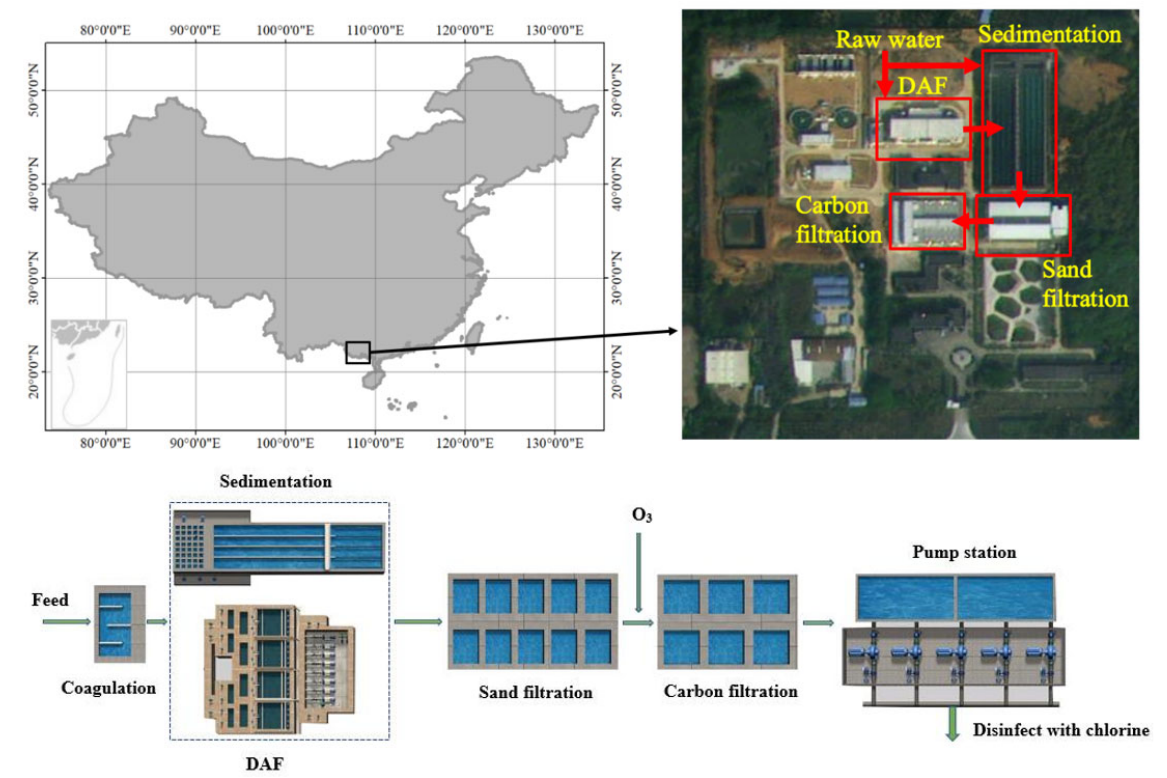
Figure 1. The water treatment process in Beijiao DWTP, Beihai, China. The scale of the feed was 96,000 m 3 ∙ d − 1 , and the dosages of the ozone and liquid chlorine were fixed at 1.6 mg ∙ L − 1 and 3 mg ∙ L − 1 , respectively. The sand filtration was backwashed every 24 h with a flow of 1440 m 3 ∙ s − 1 , with 8 min of air backwashing and 8 min of water backwashing. The activated carbon filtration was backwashed every 7 days with an 8 min water wash and every 30 days with a 5 min air wash and an 8 min water wash, both with a flow of 1310 m 3 ∙ s − 1 .